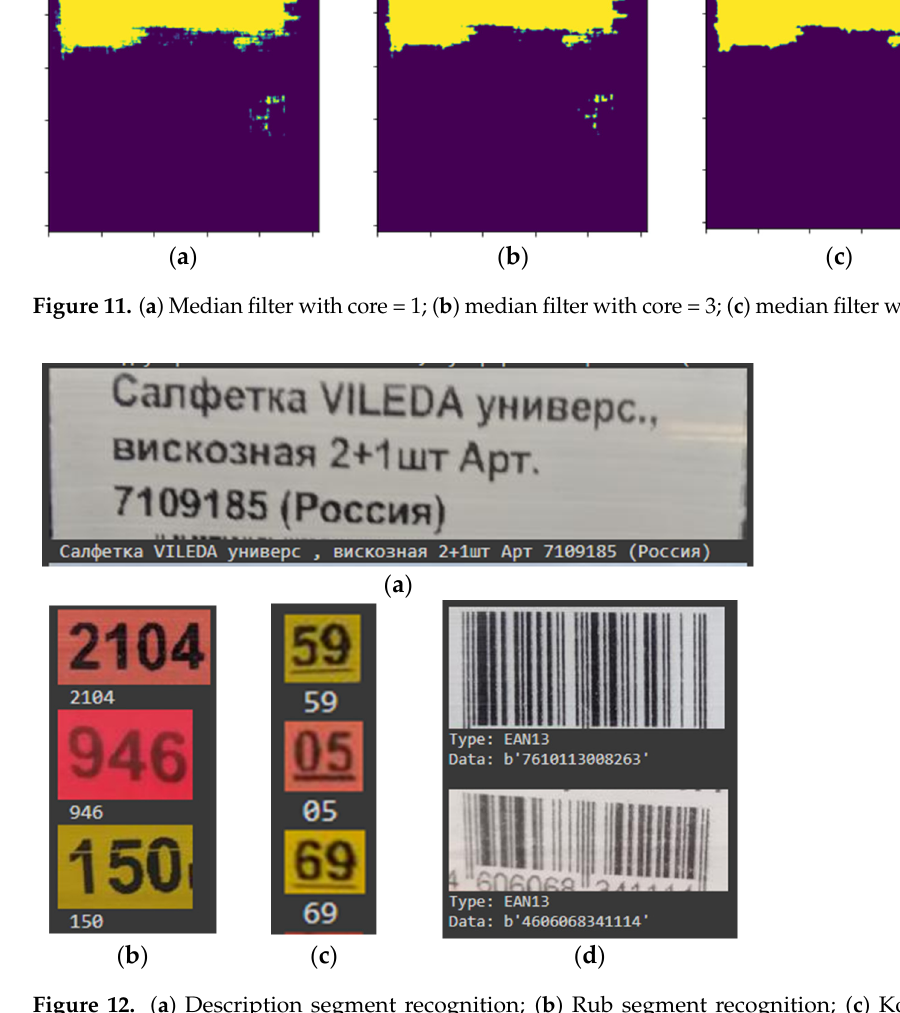
Figure 12. ( a ) Description segment recognition; ( b ) Rub segment recognition; ( c ) Kop segment recognition; ( d ) Barcode decoding using pyzbar library.